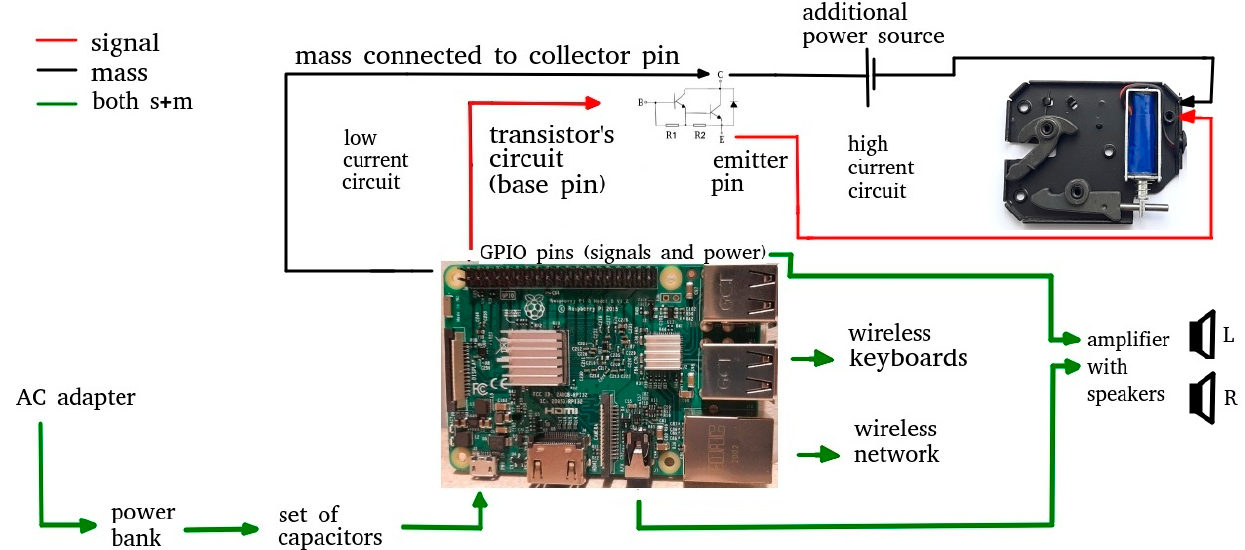
Figure 9. All the elements connected in the one coherent system (logical layout) presented in a simplified manner for the one locking mechanism only.